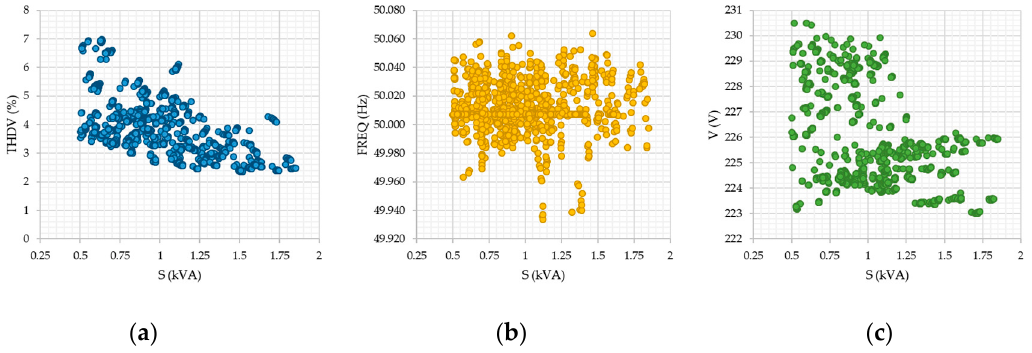
Figure 5. Pairwise relations among PQ parameters and the related load on a 100% SoC battery for: ( a ) voltage total harmonic distortion, ( b ) frequency, ( c ) voltage.